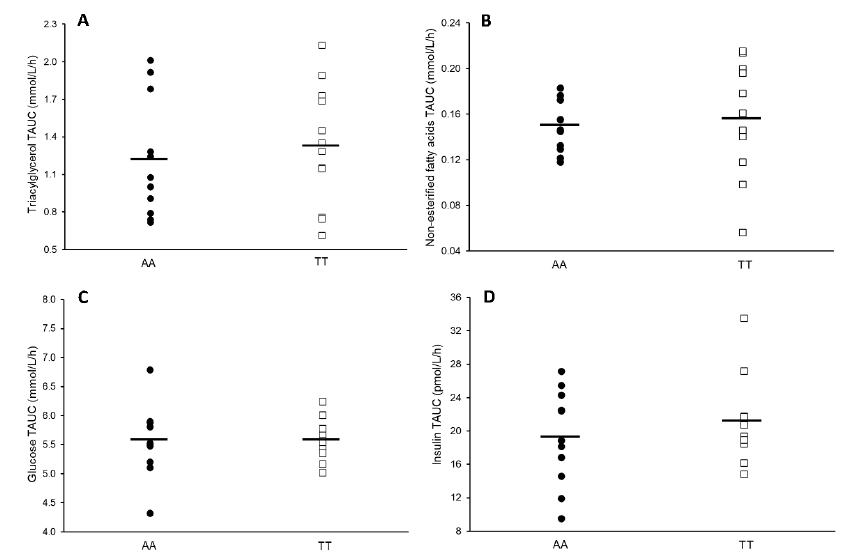
Figure 3. Time-averaged total area under the curve (TAUC) values for triacylglycerol ( A ), non-esterified fatty acids ( B ), glucose ( C ), and insulin ( D ) in AAs ( n = 12) and TTs ( n = 12) (AAs: filled circles; TTs: unfilled squares). Data points represent individual participant values and the black line represents the mean. Abbreviations: TAUC, total area under the curve.